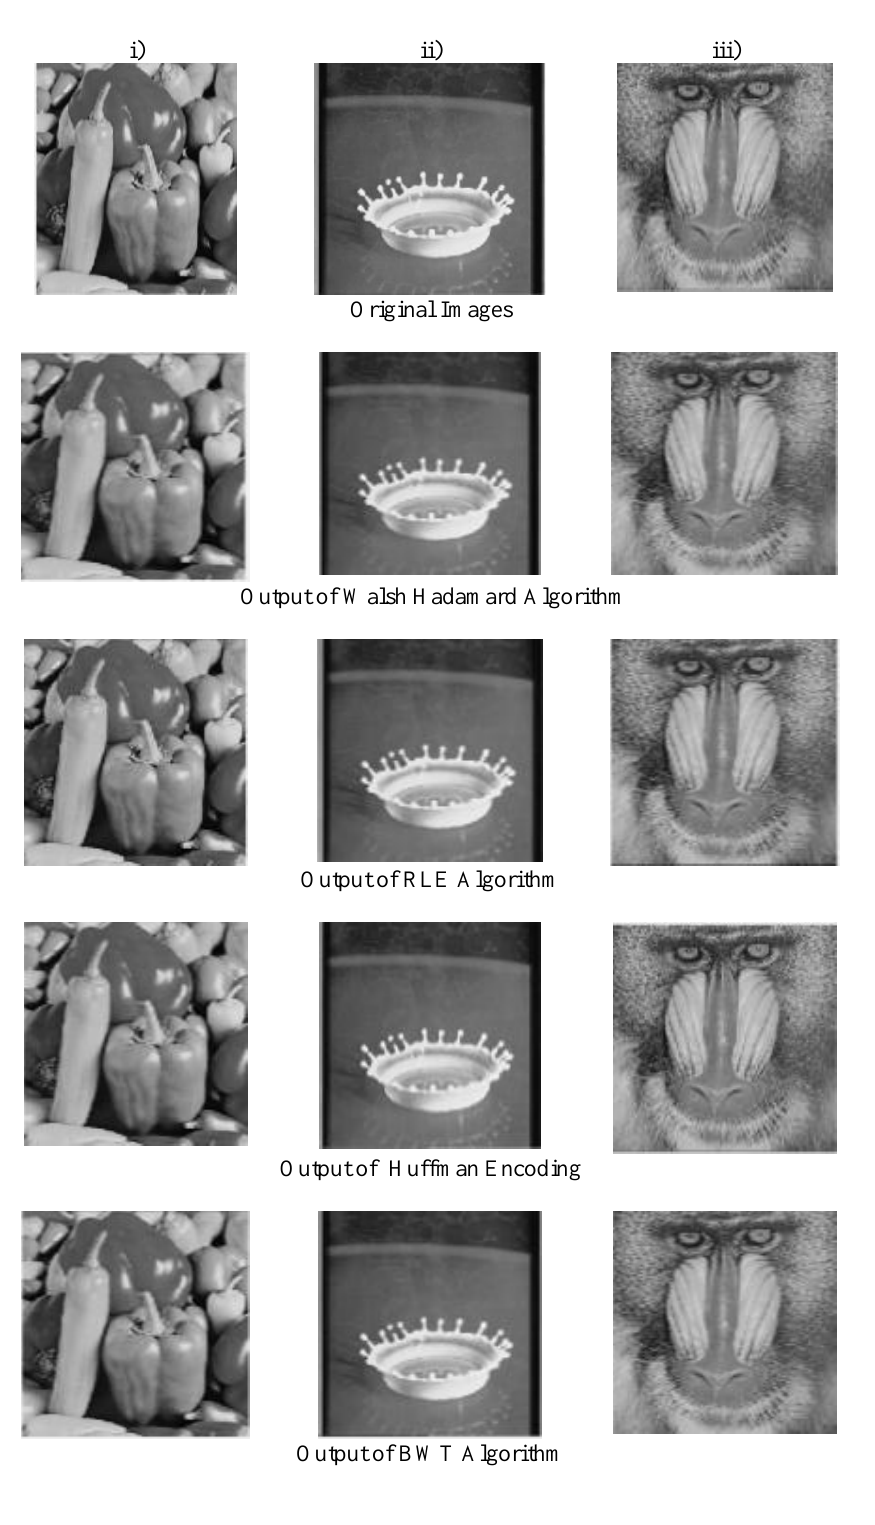
Figure 6 . Output of Images using Lossless Compression